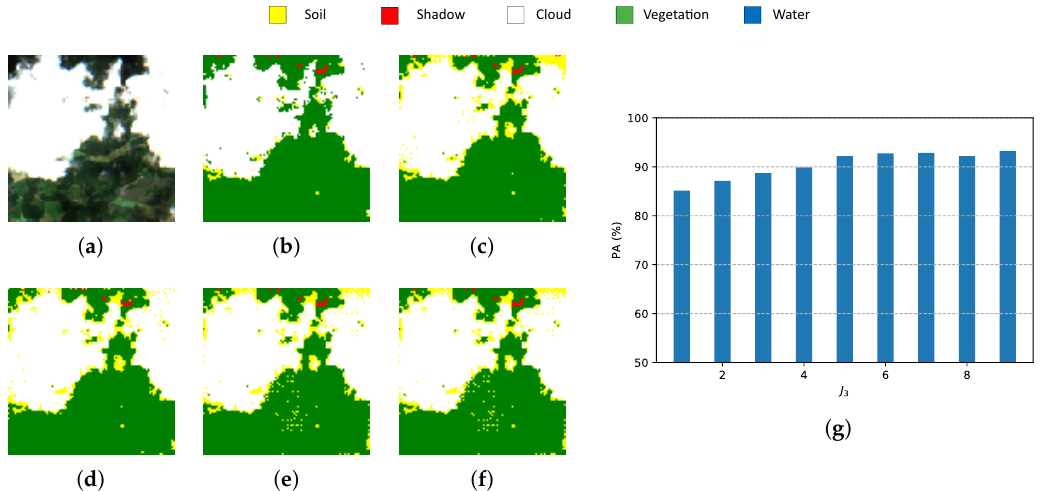
Figure 12. Qualitative results testing a scene of interest with abundant presence of clouds. ( a ) Original true color scenario of 128 × 128 pixels, in Central Europe: ( b ) five classes semi-manually labeled ground truth of the MSIs, ( c ) classification with an unsupervised normalized difference index (NDI) fusion algorithm, and ( d ) output prediction after 100 epochs in the FCN used for this work without data compression. ( e ) PCA-FCN framework output; ( f ) prediction of the whole framework HOOI-FCN proposed in this work; and ( g ) PA behavior of the HOOI-FCN versus number of tensor